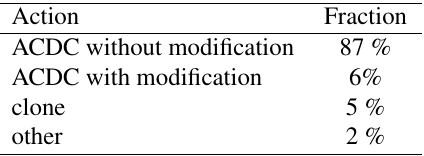
Table 1: Actions taken by the operator